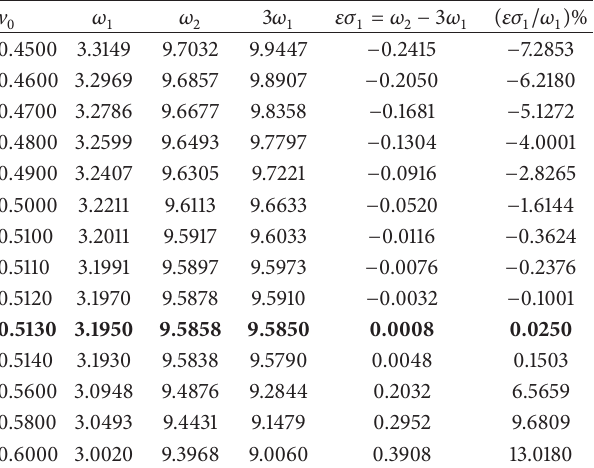
Table1:Variationofnaturalfrequenciesforthefirsttwomodeswith mean travelling velocity V 0 showing 3: 1 internal resonance for V 𝑓 = 0.2